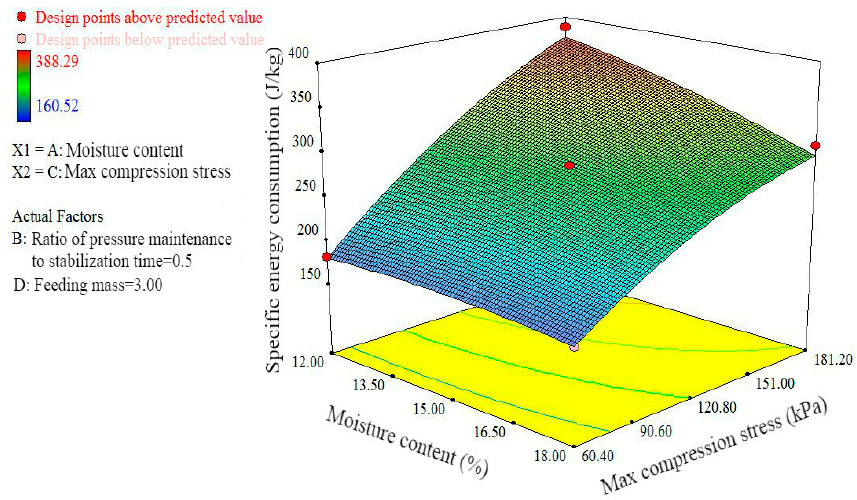
Figure 6. Effects of moisture content and max compression stress on specific energy consumption (ratio of pressure maintenance to stabilization time of 0.5 and feeding mass of 3 kg).